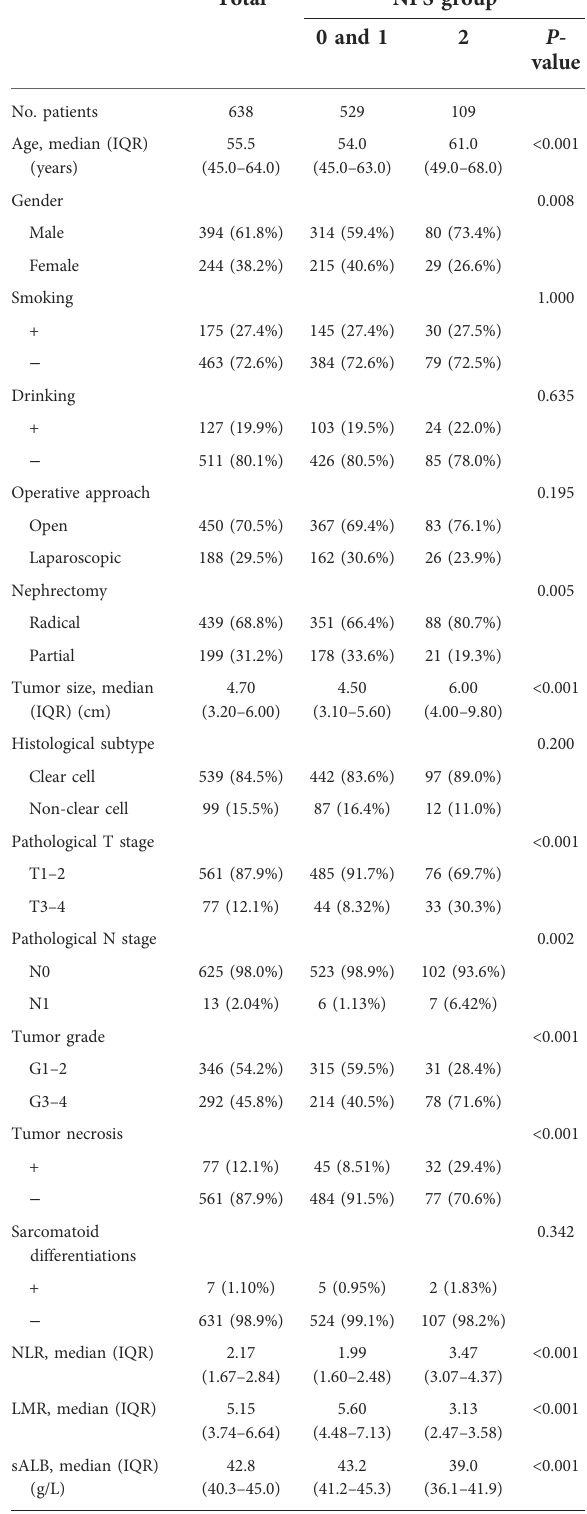
TABLE 1 Clinical characteristics of the patients between the NPS groups 0 and 1 and the NPS group 2.